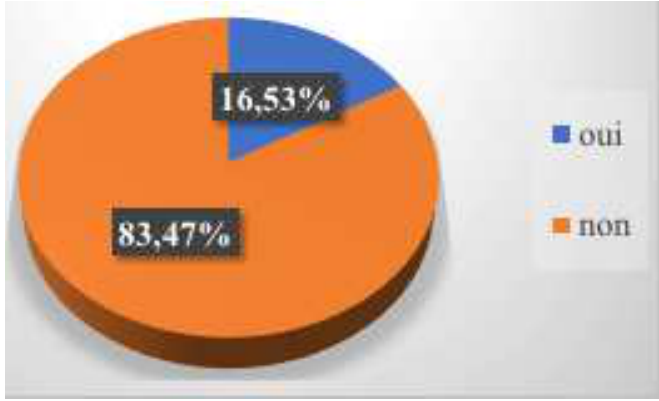
Fig. 3. Proportions d’accès aux dispositifs technologiques Fig. 5. Formations antérieures en